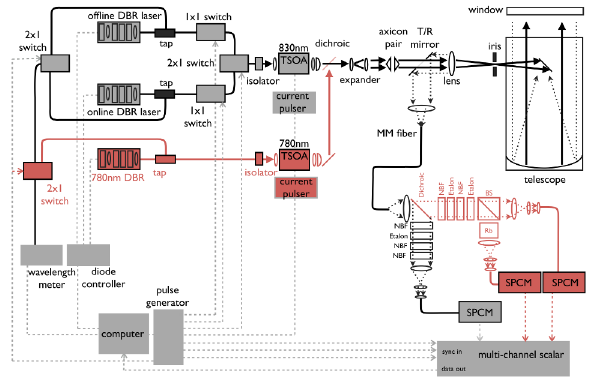
stable, and eye-safe, operation. A multistage filtered receiver is implemented to allow continuous measure- ment in high background conditions (e.g., bright daytime clouds).